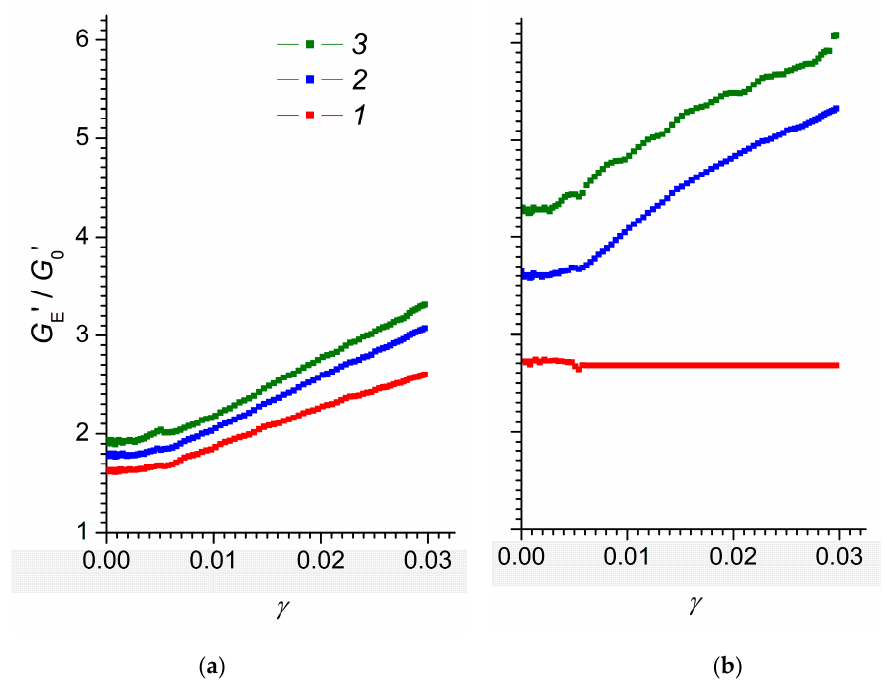
Figure 5. The storage modulus magnitude of the electrorheological effect for elastomers ( a ) MnO 2 -0 and ( b ) MnO 2 -E as a function of the degree of deformation in electric fields with strengths 1 —0.4, 2 — 1.2, 3 —2.0 kV/mm. 2 —1.2, 3 —2.0 kV /